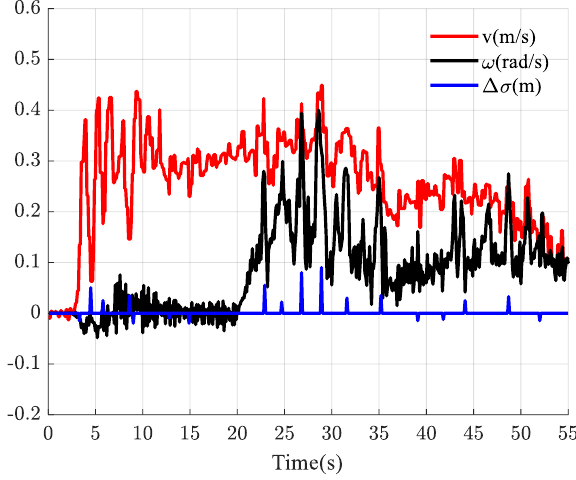
Figure 17. The relationship between the generalized speed of the tracked robot and the slipping